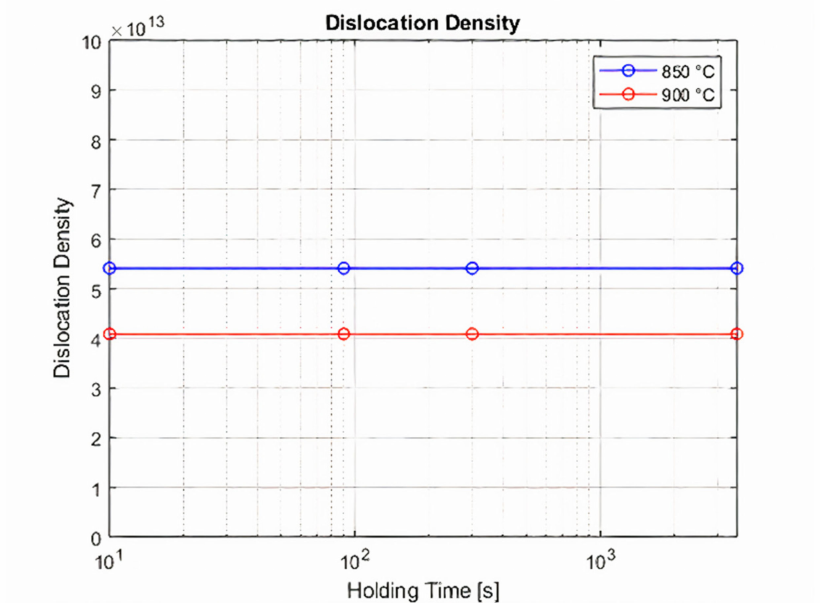
Figure 15. Results of dislocation density simulations for different temperatures and holding